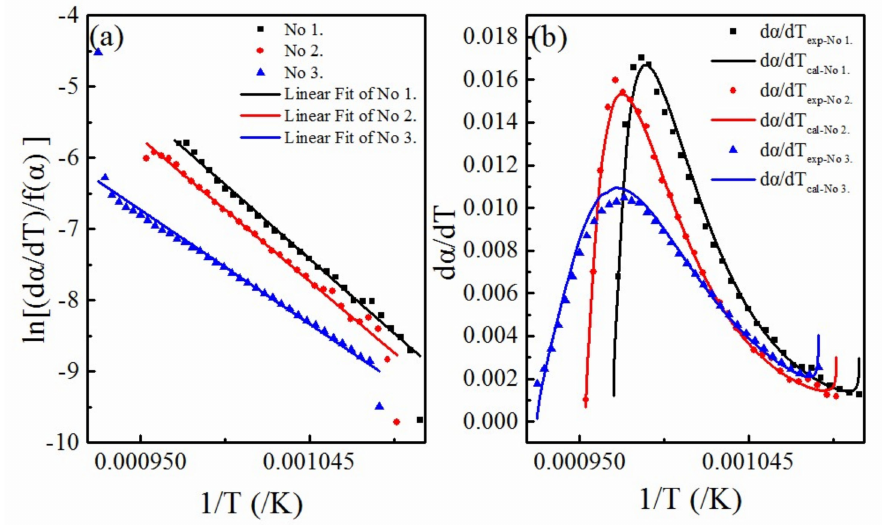
(cid:20) d α (cid:21) dT against 1 ; ( b ) The relative error curves of the experimental T f ( α )